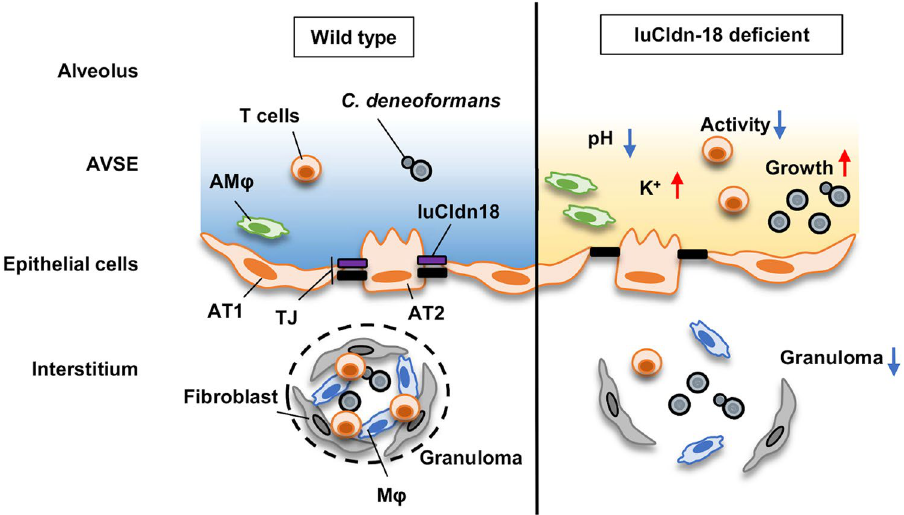
Figure 7. Summary of the role of luCldn-18 in host defense against infection with C. deneoformans . luCldn-18 deficiency induces acidification and high K + ion concentration in the alveolar space. Alveolar acidification and high K + ion concentrations inhibit the activation of T cells in response to cryptococcal infection and thereby suppress granuloma formation. In addition, the increased replication efficiency of this fungus at low pH values increases the fungal burden in luCldn-18-deficient mice. Consequently, luCldn-18 indirectly helps prevent cryptococcal infection by maintaining homeostasis of the alveolar space microenvironment. AVSE, alveolar subphase fluid. TJ, tight junction. AMφ, alveolar macrophages. AT1, alveolar type I cells. AT2, alveolar type II cells. This image was drawn by Ko